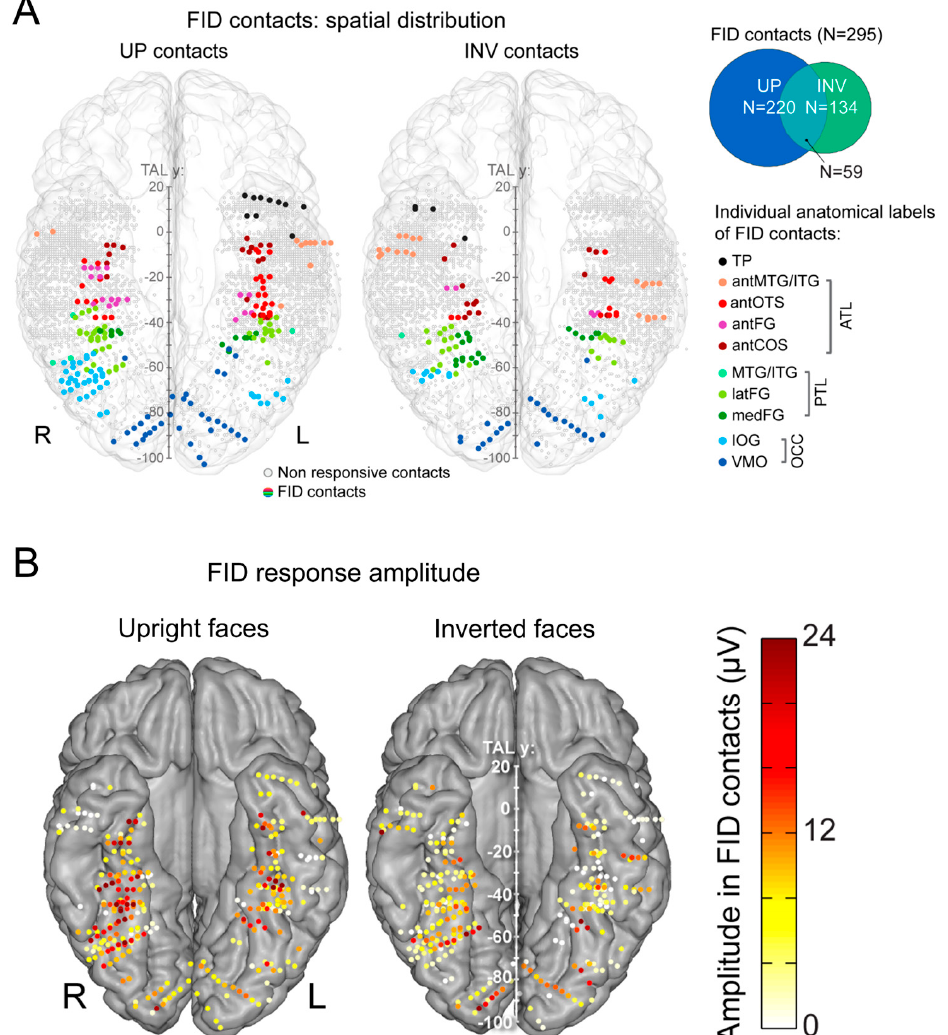
Figure 17. ( A ) Maps of all 3825 VOTC recording contacts across the 69 individual brains tested in the study of Jacques et al. (2020) [188]. The maps are displayed in the Talairach space using a transparent reconstructed cortical surface of the Colin27 brain (ventral view). Each circle represents a single recording contact. Color-filled circles correspond to face identity discrimination (FID) contacts, either defined as UP contacts (left map, N = 220, see Venn diagram inset on the right) or INV contacts (right map, N = 134). UP and INV contacts are color-coded according to their anatomical location in the original individual anatomy (see the legend on the right). White-filled circles correspond to contacts on which no significant FID responses were recorded. For visualization purposes, individual contacts are displayed larger than their actual size (2 mm in length). Values along the Y axis of the Talairach coordinate system (antero-posterior) are shown near the interhemispheric fissure. ( B ) Significant FID contacts color-coded according to their respective amplitude for both upright and inverted faces.